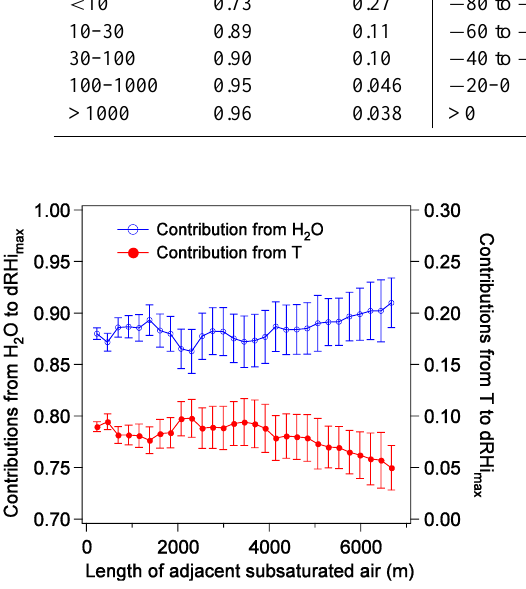
Fig. 8. Contributions from H 2 O ( d RHi q , left ordinate) and T ( d RHi T , right ordinate) to d RHi max using various scales of hor- izontally adjacent subsaturated air for comparison. d RHi q and d RHi T are in blue circles and red dots, respectively. Error bars rep- resent 1 standard deviation of the linear fit for d RHi q or d RHi T . The large contributions from H 2 O to d RHi hold for all length scales of adjacent subsaturated air from ∼ 230m to 6.7km.